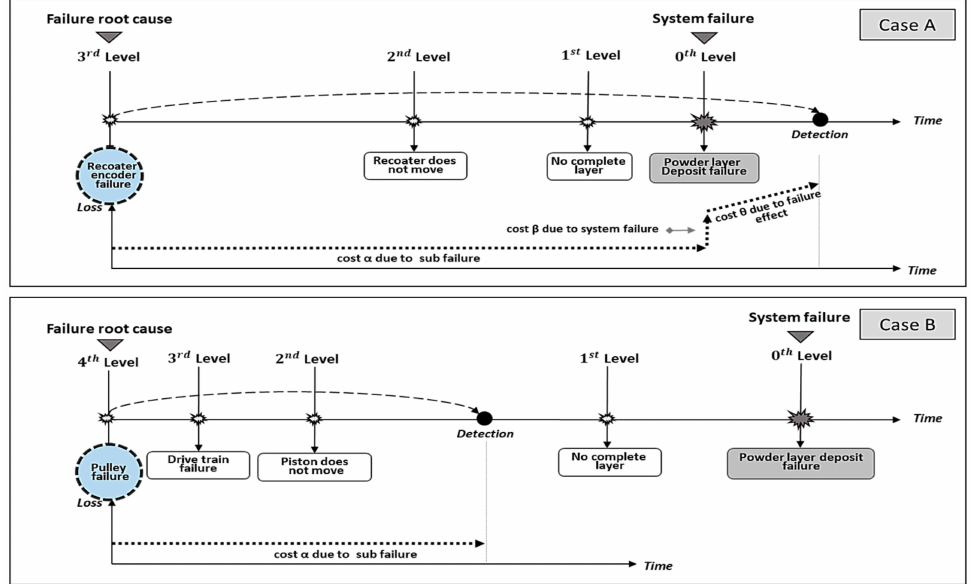
Figure 2. Loss depending on the detectable time in hierarchical failure